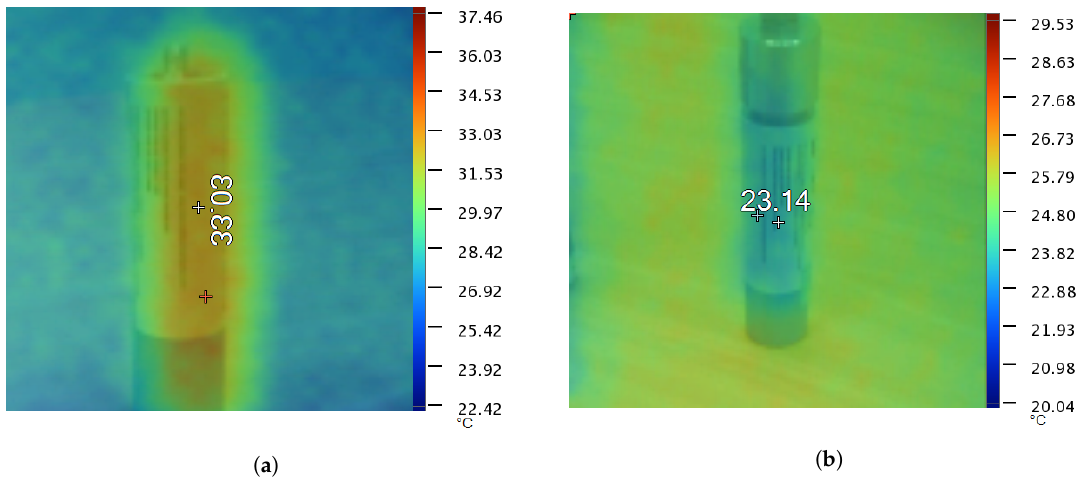
Figure 8. ( a ) Temperature of the fuel stick before connecting to fuel cell stack; ( b ) temperature of fuel stick after being connected to fuel cell stack for about ten minutes. Fuel stick temperature drop test 1—captured by thermal imaging device 1.